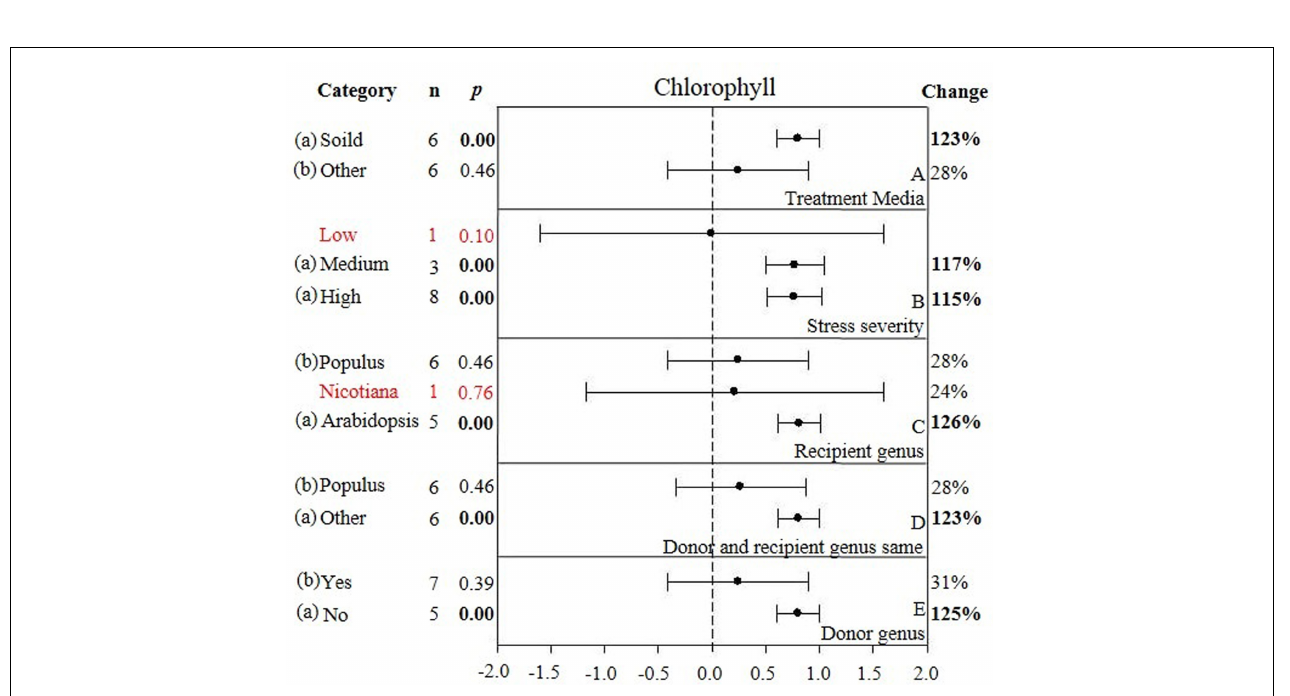
FIGURE 5 | Weighted summary effect sizes (ln R ) and 95% CIs showing how moderator variables affect the extent to which CIPK transformation modifies chlorophyll. (A) Treatment media, (B) Stress severity, (C) Recipient genus, (D) Donor and recipient genus same, and (E) Donor genus. A p ≤ 0.05 indicates that the moderator level was significantly different than zero; n stands for the number of